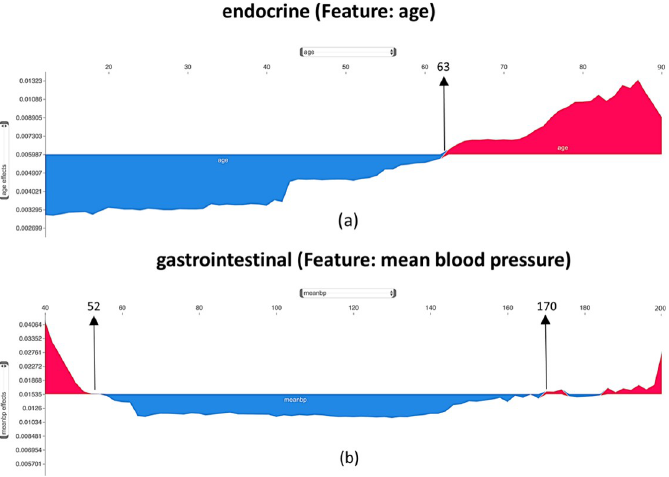
Fig 3. Force plots of the most important features in mortality prediction of patients in endocrine and gastrointestinal disease groups.